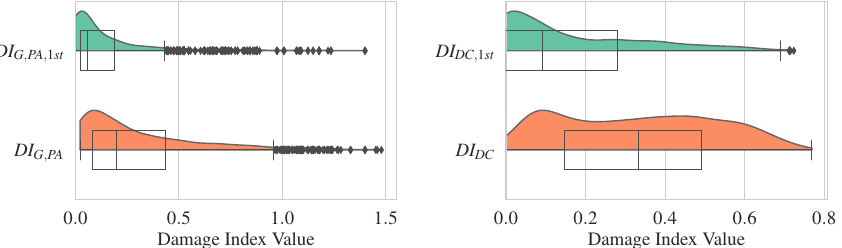
Figure 4. Violin and box plots of the damage indices.